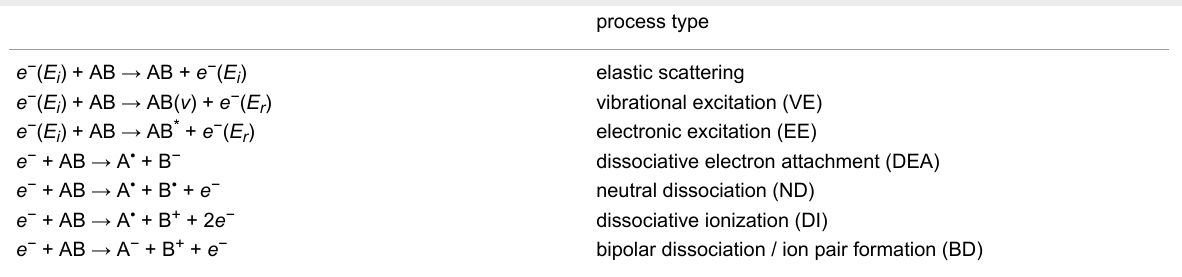
Table 1: Electron–molecule interaction processes relevant for FEBID according to [3]. Rotational excitations are not explicitly included. E i : initial kinetic energy of electron, E r : residual kinetic energy of electron after